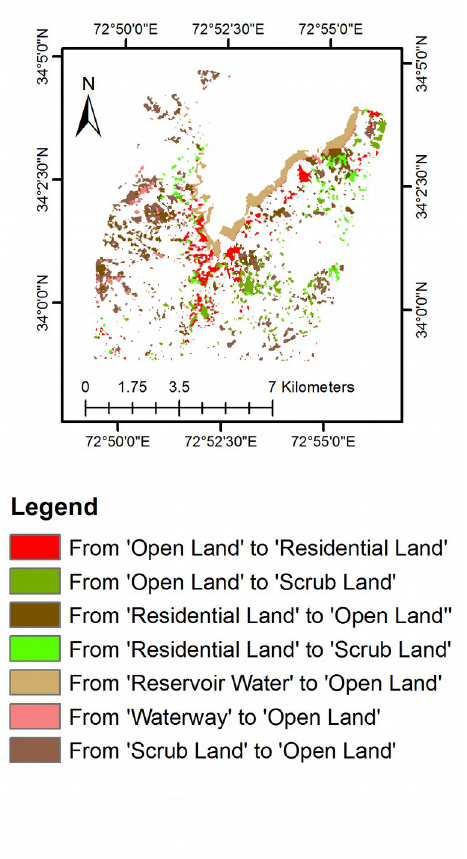
Figure 7. S ummer to autumn seasonal change detection